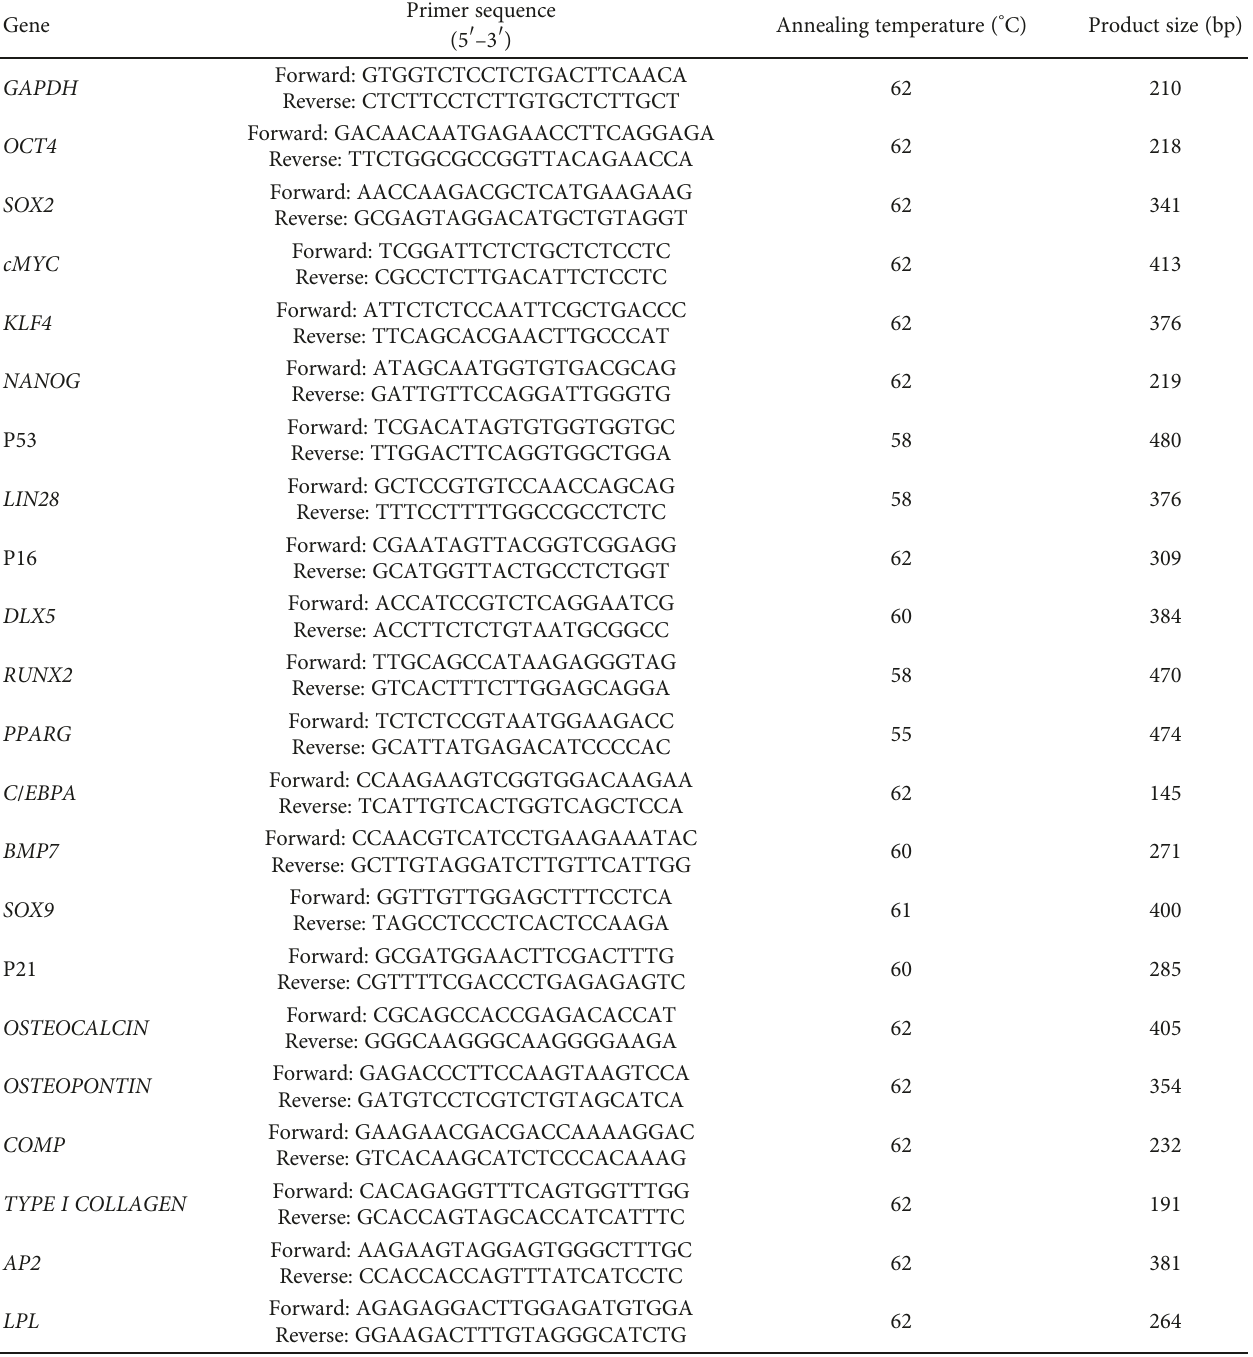
Table 1: Primer sequences used for